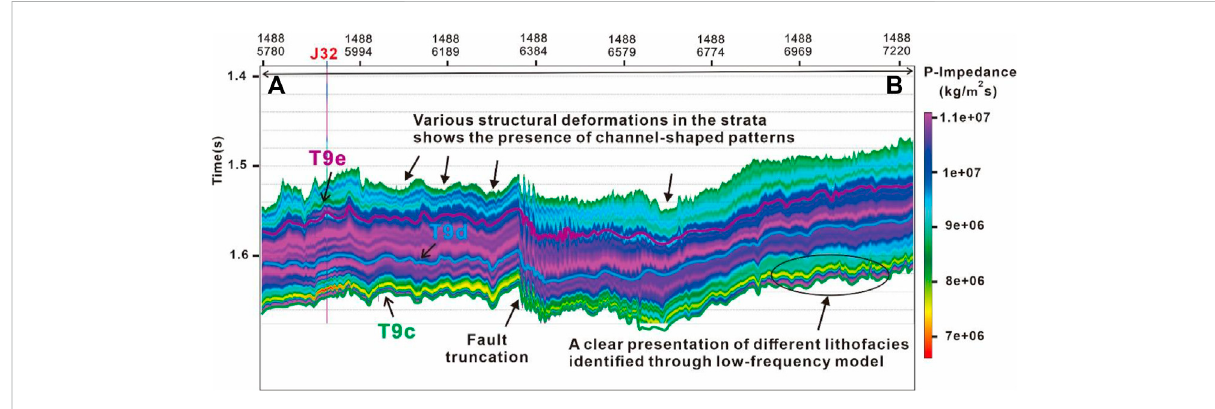
FIGURE 6 Low-frequency model of the ZOI that shows the presence of fault truncations and channel-shaped patterns associated with structural variations. A highlighted zone evidently highlights the presence of various